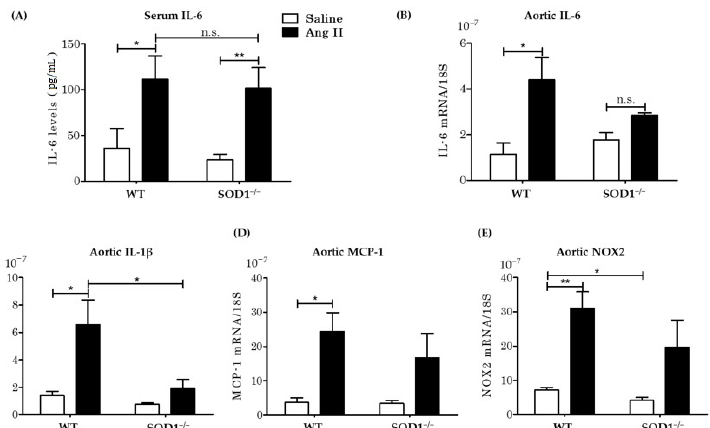
Figure 5. Serum IL-6 concentration and mRNA expression in aortas. ( A ) Serum IL-6 levels were analyzed by the ELISA test ( n = 9–10 per group. * p < 0.05 ** p < 0.01 n.s.: not significant). ( B – E ) The local aortic IL-6 ( B ), IL-1 β ( C ), MCP-1 ( D ) and NOX2 ( E ) levels were detected as mRNA expressions, which were compensated with an internal control: 18S ( n = 4–8 per group; * p < 0.05, ** p < 0.01 n.s.: not significant). Error bars represent SEM. IL-6: interleukin 6; IL-1 β : interleukin 1 β ; MCP- 1: Monocyte Chemotactic Protein-1; NOX2: NADPH Oxidase